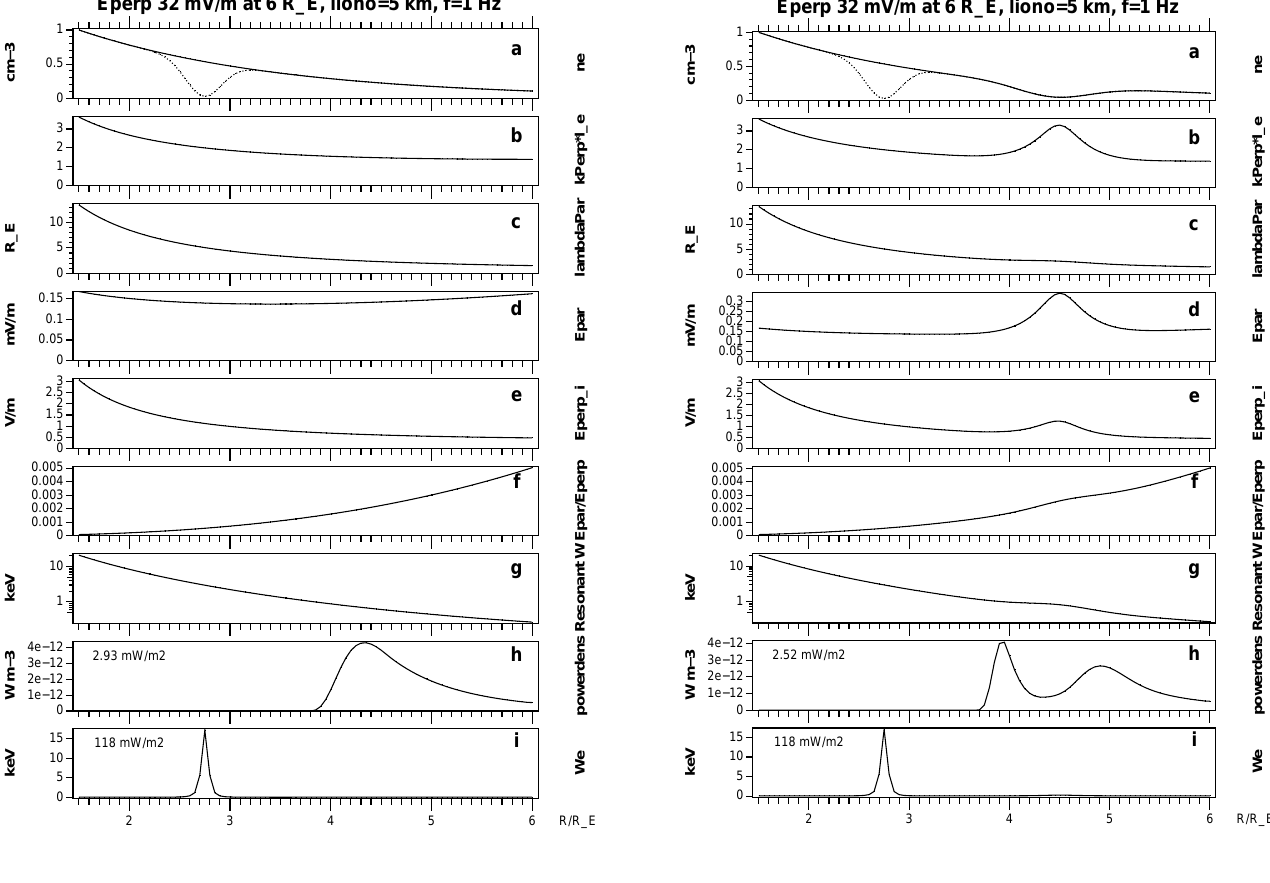
Fig. 5. Panels from top to bottom: electron density profile with rapidly varying “cavity” density profile shown as dotted (a) , the dimensionless parameter k ⊥ λ e (b) , parallel wavelength (c) , wave parallel electric field amplitude (d) , wave perpendicular field mapped to ionosphere with flux tube scaling (e) , ratio of parallel and perpendicular wave electric fields (f) , energy of parallel electron that moves with the parallel phase velocity of the wave (g) , power density of resonant energisation with radially integrated and mapped-to-ionosphere value shown textually (h) , energy to which electrons must be accelerated to carry the parallel current of the wave with mapped-to-ionosphere energy flux value corresponding to the maximum shown textually (i) . Left sub-figure is without and right sub-figure with assumed ARS cavity (notice difference in panels (a). Only panel (i) relates to the low-altitude cavity, the other panels have been computed under the assumption of a small wavelength which is not valid in the low-altitude